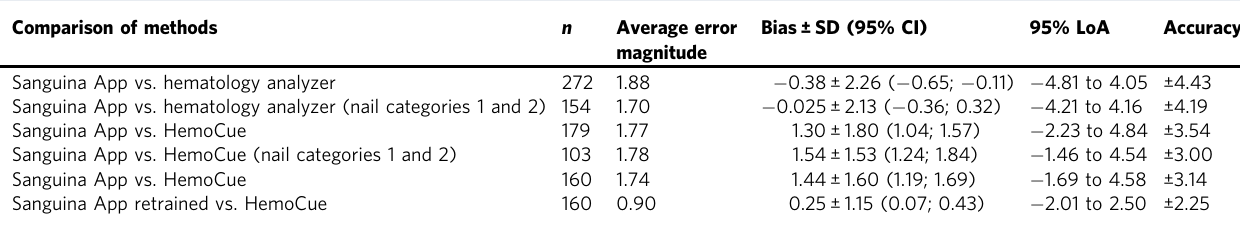
difference of 0.25 g/dl was calculated (Fig. 3, panel c). The average error magnitude was 0.90 g/dl (Table 3, panel c). The sensitivity (20%) showed a slight increase, the speci fi city remained high at 90%. PPV and NPV stayed almost unchanged at 40% and 77%, respectively (Table 5, panel c). Relationship of nail category with validity of the App . In the clinic-based sample, analysis of validity using a subset of nails in categories 1 and 2 for comparison with the reference revealed and Supplementary Fig. 5, panel a). ROC analysis for nail